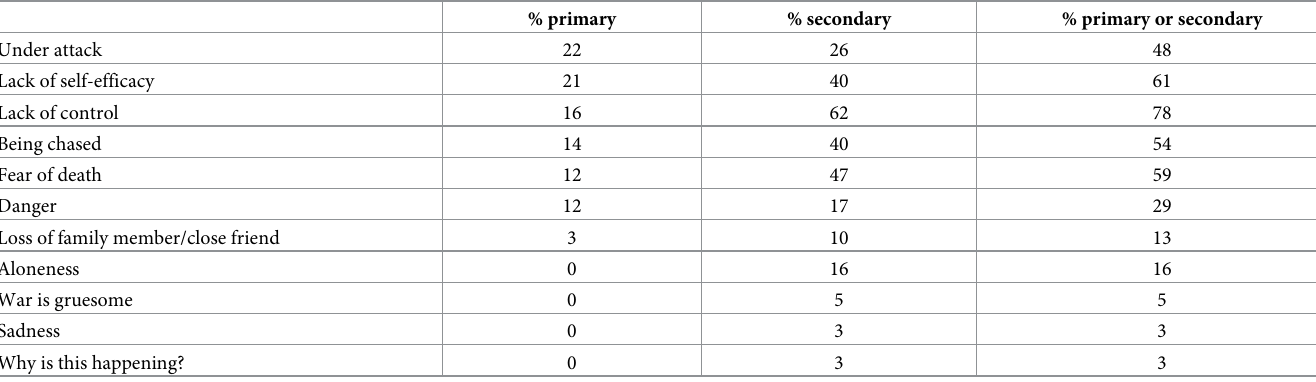
Table 3. Primary and secondary nightmare themes ( n = 58).